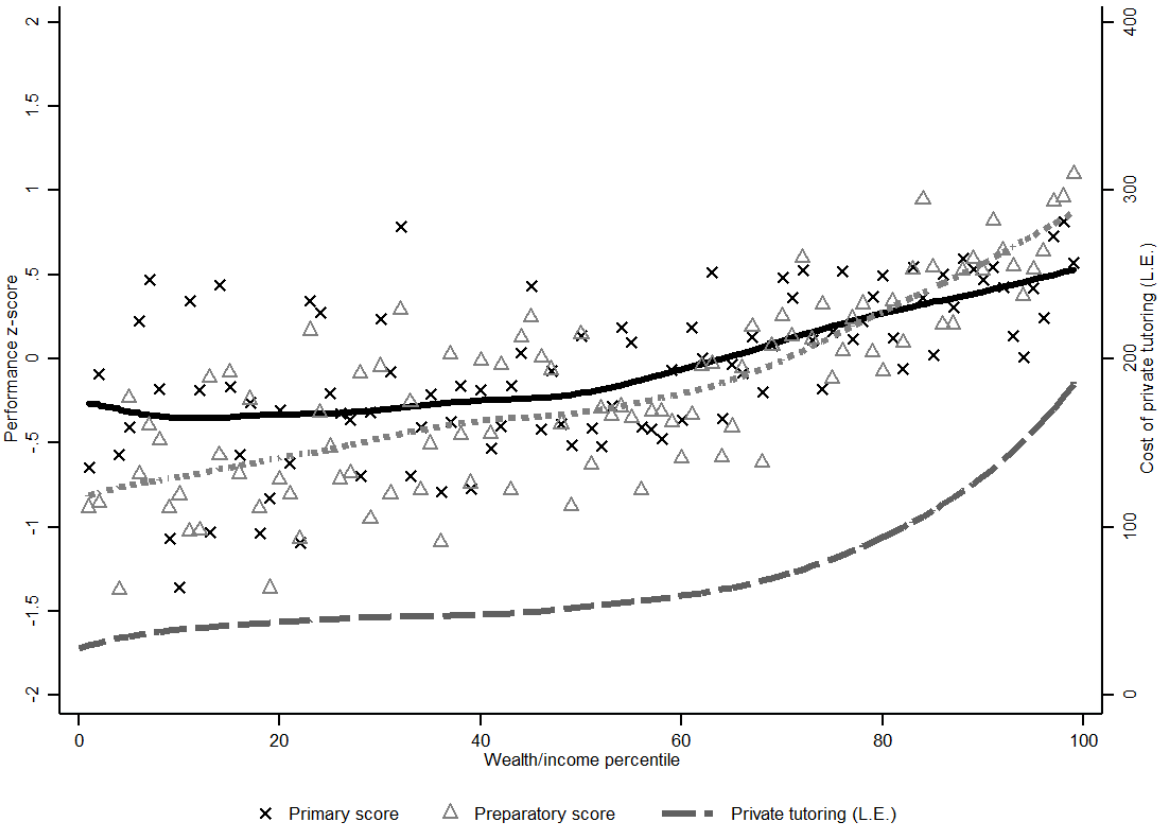
Figure 2: Mean scores of male students in each wealth/income percentile at primary and preparatory levels (y-axis 1), alongside mean amount spent on private tutoring per month (y-axis 2). Note: Primary score analysis, n = 774; preparatory score analysis, n = 865; private tutoring analysis, n =